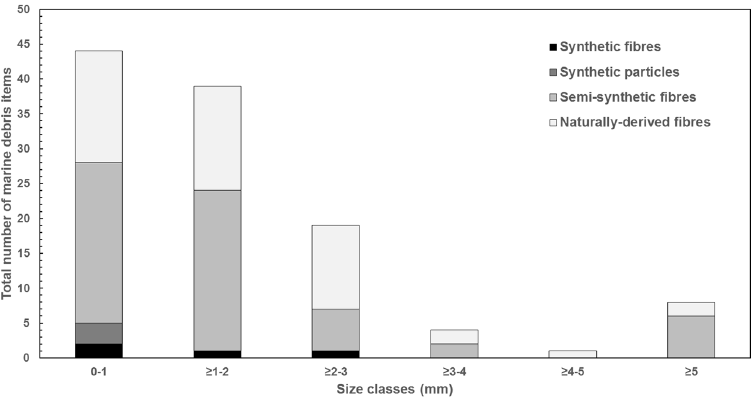
Figure 6. Size-frequency distribution of marine microdebris items in juvenile coral trout. Marine microdebris items were detected in the gastrointestinal tracts dissected from 19 out of the 20 individual juvenile coral trout ( Plectropomus leopardus and P. maculatus ), collected on reefs around four reef islands in the Great Barrier Reef World Heritage Area, Australia, in